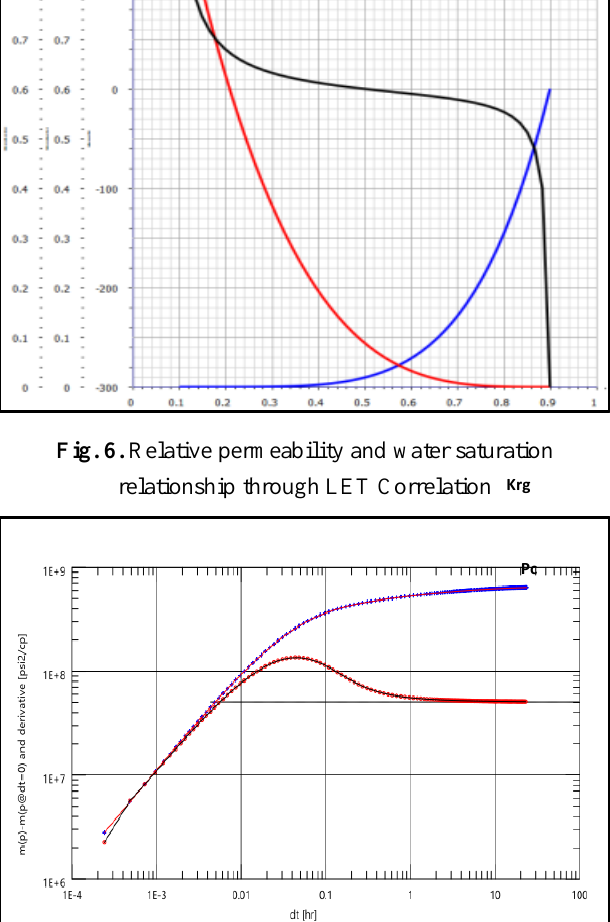
Fig. 7. Logarithmic plot of compressibility versus confining pressure